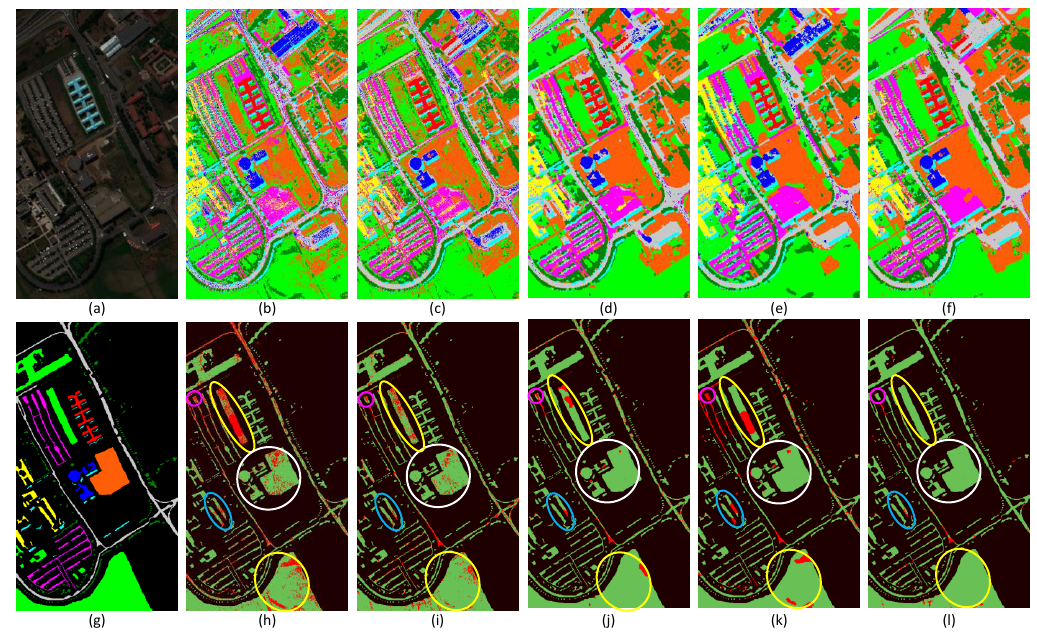
Figure 2. Classification results of Pavia University dataset. ( a ) Three-band false color image. ( g ) Ground truth. ( g , f ) Classification maps obtained by MLR, SVMs, CRFs, SVRFMC, and HSVRFs. ( h – l ) The corresponding difference images of ( b – f ) compared with the ground truth in ( g ). Black regions represent pixels without ground truth. In the remaining part, green regions represent correctly classified pixels and red regions represent wrongly classified